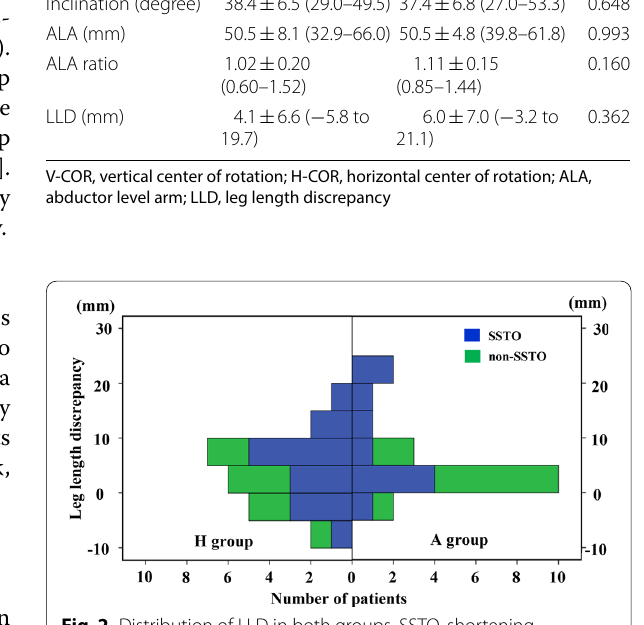
Fig. 2 Distribution of LLD in both groups. SSTO, shortening subtrochanteric